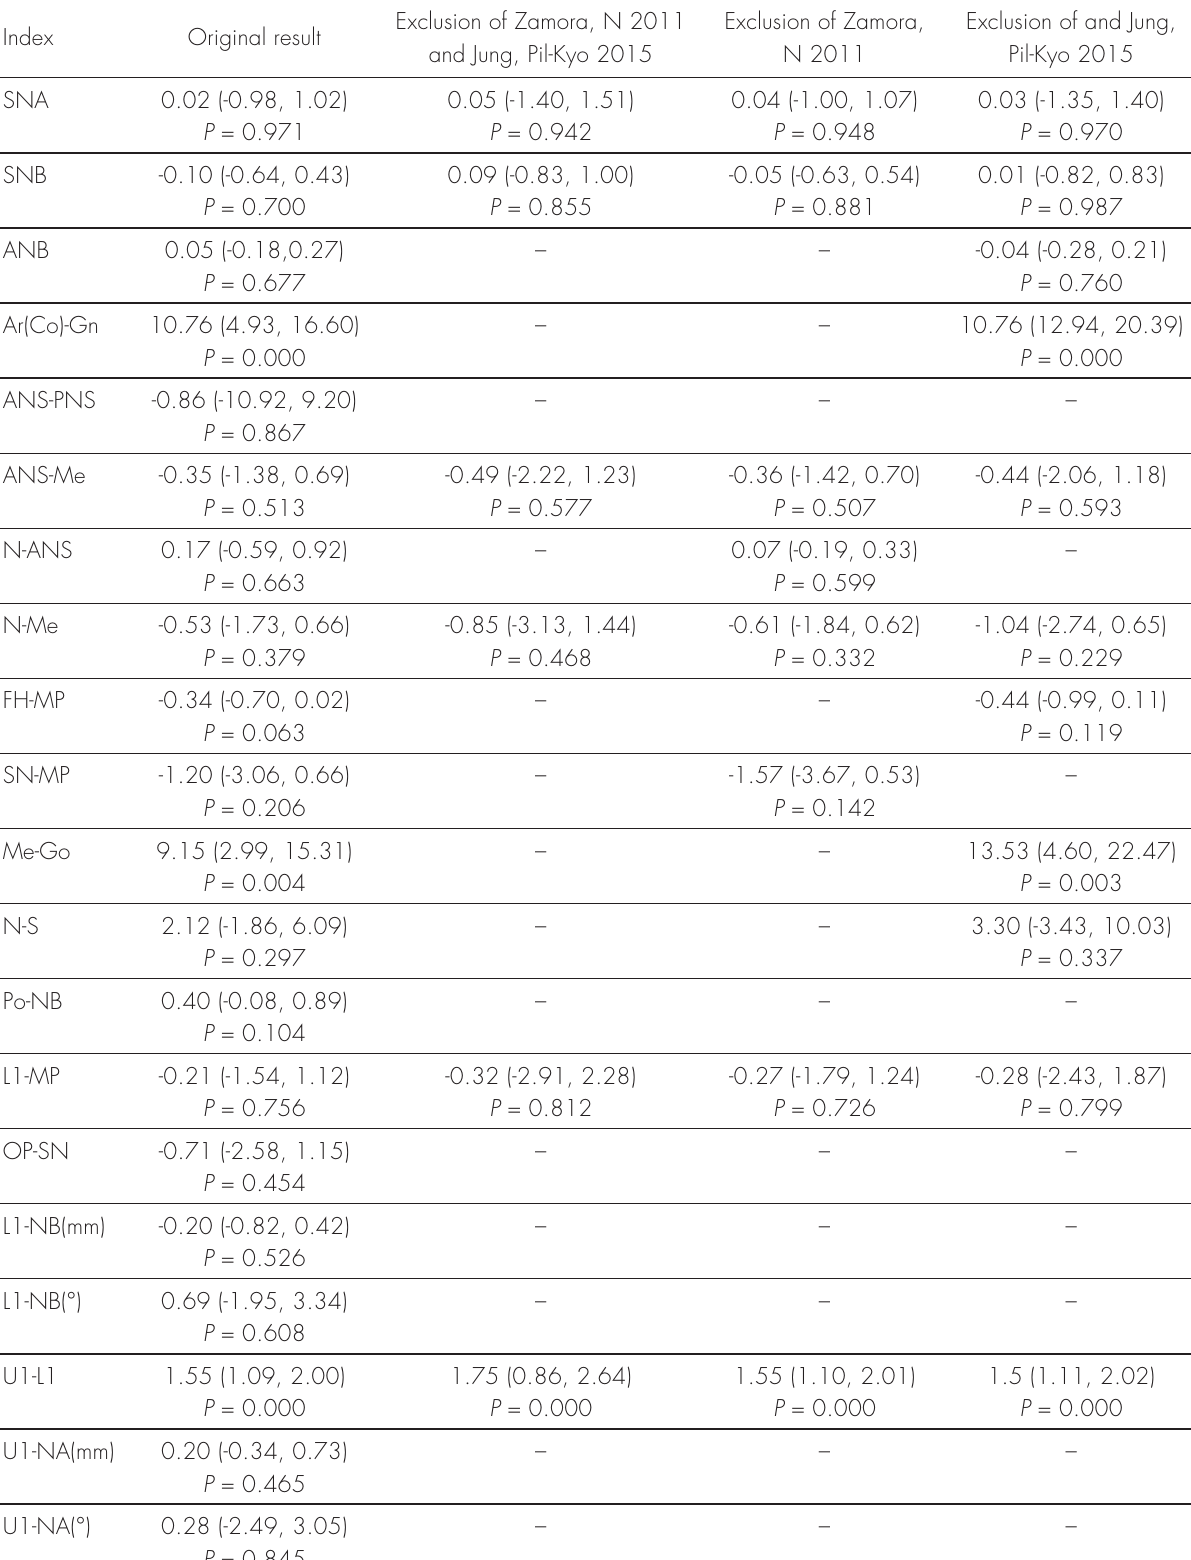
Table VI. Result of sensitivity